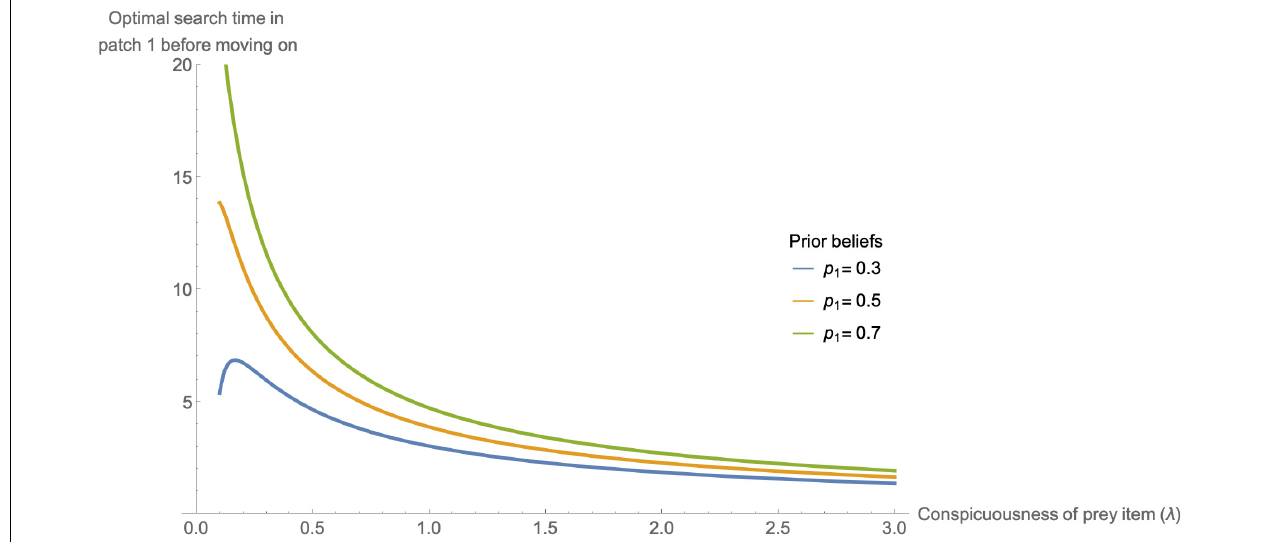
FIGURE 3 | The optimal maximum search time of a predator looking for a prey item in patch 1 (the patch it believes the prey is most likely hiding) before abandoning its search and looking for prey elsewhere. Here we set the average long-term rate of gain from abandoning search ( g ) to be 0.02 and vary the conspicuousness of the fleeing prey item ( λ ) from 0.1 to 3 (so that it is always profitable to pursue the prey item so long as p 1 > 0.2). The predator’s prior probability that the most plausible patch 1 contains the prey item ( p 1 ) is considered at three different levels (0.3, 0.5, and 0.7). In general, the higher the conspicuousness of the prey item, the shorter the maximal search time before abandonment (although it may pay a predator to search for cryptic prey items of borderline profitability for a relatively short period of time, hence a peak). The more confident the predator is that the prey have landed in the patch, the longer it should search.